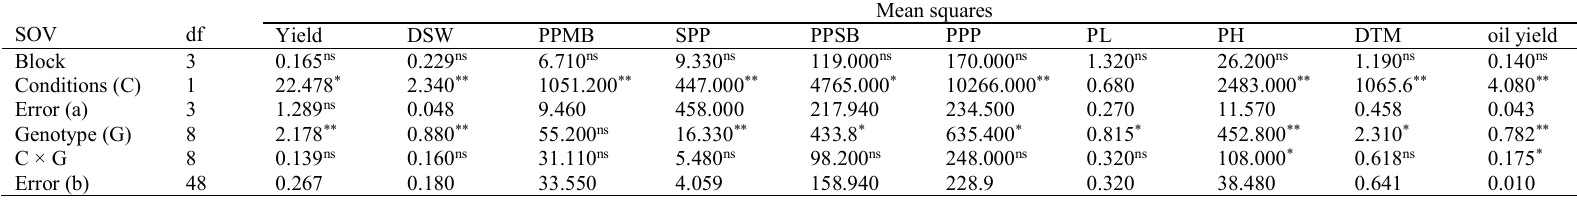
Table 1. Analysis of variance for studied traits of Brassica napus genotypes as split plot experiment based on randomized complete block design. Where Source of variation (SOV), degree of freedom (df), coefficient of variations (CV), plant height (PH), days to maturity (DTM), pods per main branch (PPMB), pods per sub- branch (PPSB), pods per plant (PPP), seed per pod (SPP), 1000 seeds weight (DSW) and pod length (PL). ns , * and ** indicate non-significant, significant in P<0.05 and P<0.001 respectively